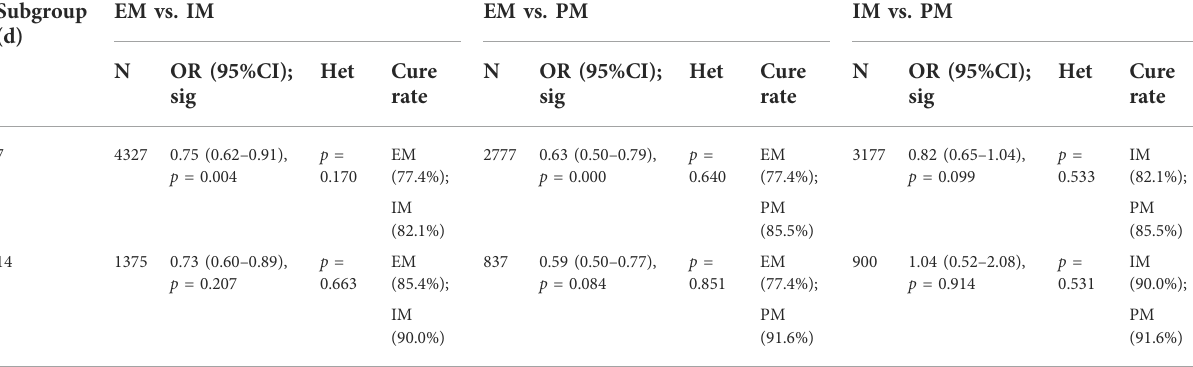
The ef fi cacy of CYP2C19 polymorphisms on the overall cure rates of H. pylori